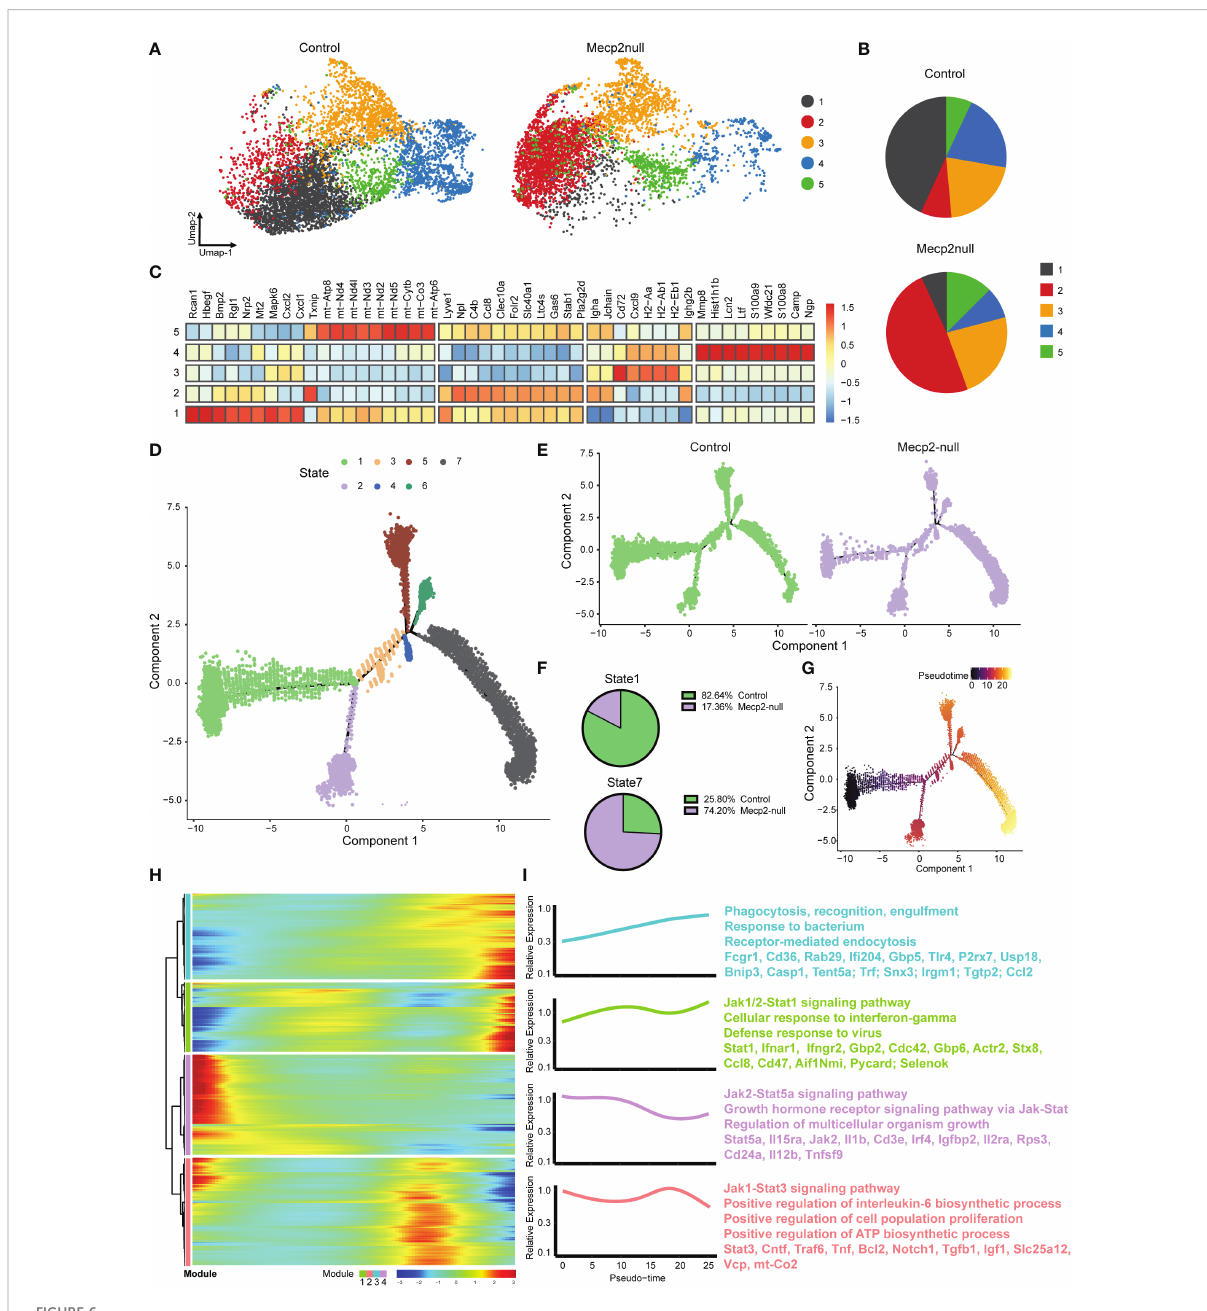
FIGURE 6 MeCP2 de fi ciency macrophages have increased response to IFN- g . (A) Umap plots showing the clusters of WT and Mecp2-de fi cienct macrophages. (B) Pie chart showing the distribution of fi ve clusters in WT and Mecp2-de fi cienct meningeal macrophages. (C) Heat map displaying the relative expression fold change (log2) of the top 50 up-regulated genes in macrophage clusters identi fi ed in (A) . (D) Visualization of the seven cell states predicted using the Monocle2 algorithm. (E) Trajectories for control and Mecp2 -null mice. (F) Numbers expressed as percentages of control (green) and Mecp2 -null (purple) macrophages in state 1 (top) and state 7 (bottom) cell populations, respectively. (G) Pseudotime of macrophages indicated by gradient color intensity from dark to bright, indicating the progression from the early to late pseudotime. (H) Heatmap displaying genes ordering during pseudotime. Color gradient from blue to red indicates low to high relative expression levels. (I) The GO and KEGG of enriched functions and pathways for the signi fi cantly differentially expressed (SDE)